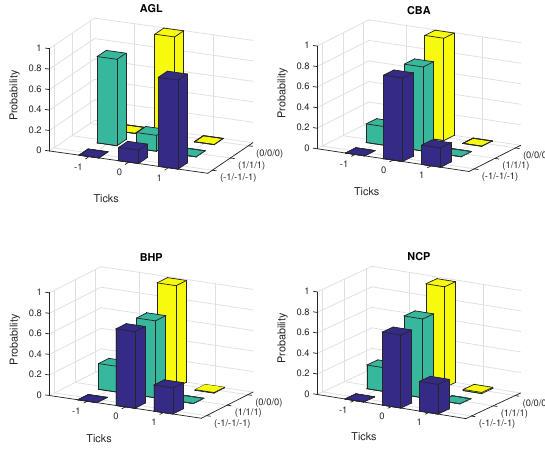
Figure 5. Distribution of estimated probabilities of direction of price change conditioned on constant, increasing and decreasing past price